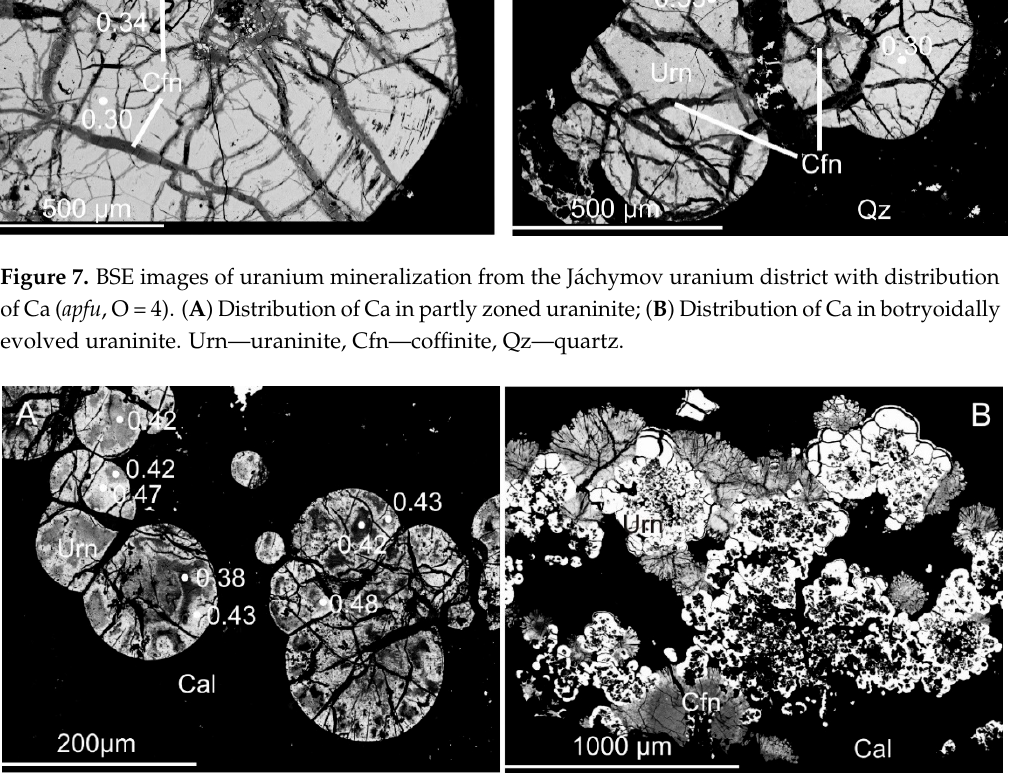
Table 1. Ranges of selected components in the uraninites studied. Locality